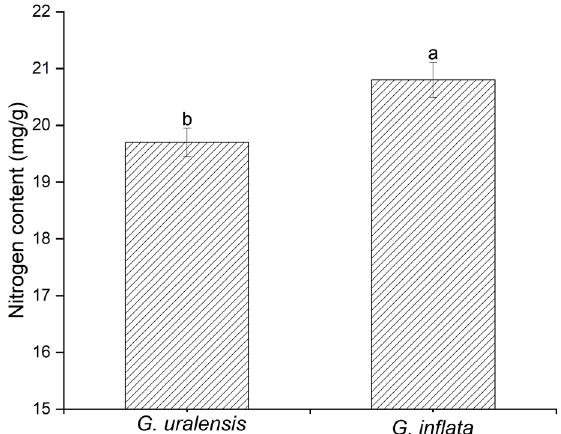
Figure 6. Total tannin content in the leaves of two licorice ( Glycyrrhiza ) species. Means with differing letters are significantly different (P < 0.01).